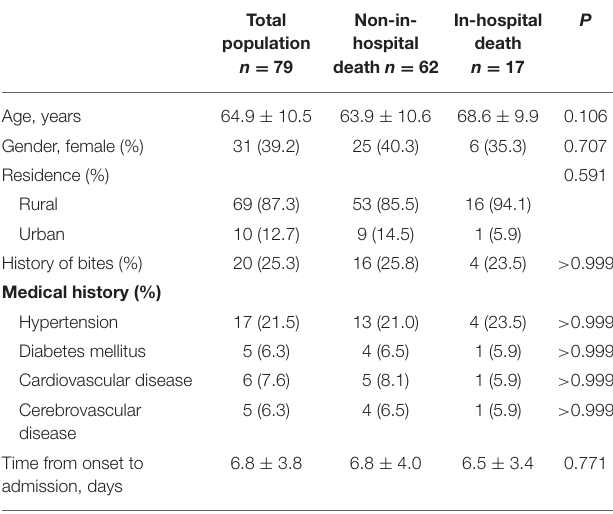
TABLE 1 | Baseline demographic and medical characteristics of the study population.